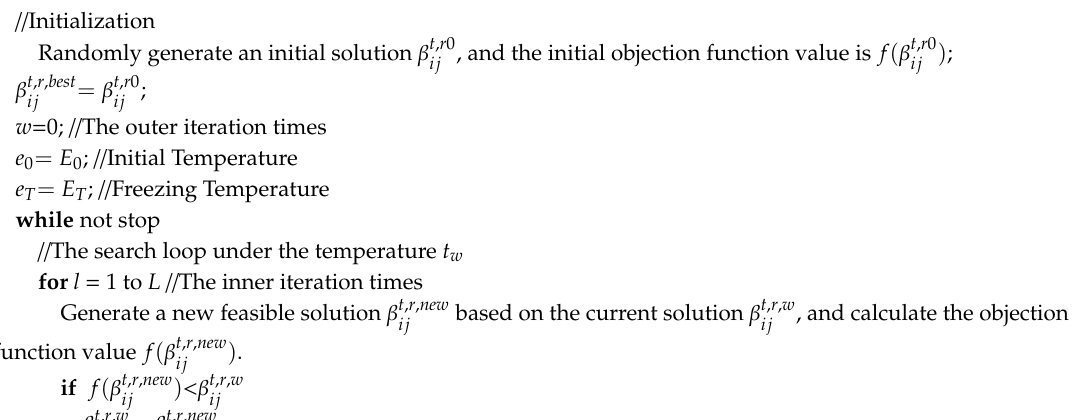
Algorithm 1 Pseudo code of SA